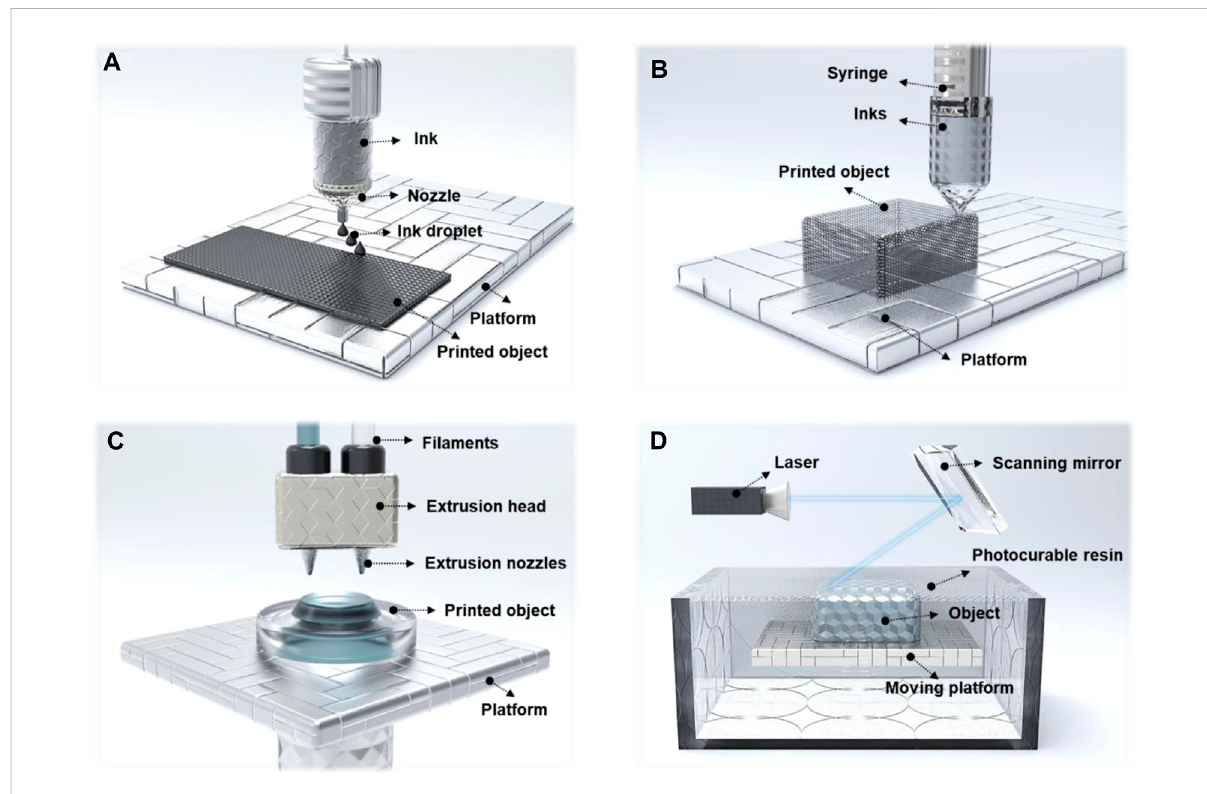
FIGURE 1 Schematic illustration of (A) IJP, (B) DIW, (C) FDM, (D)